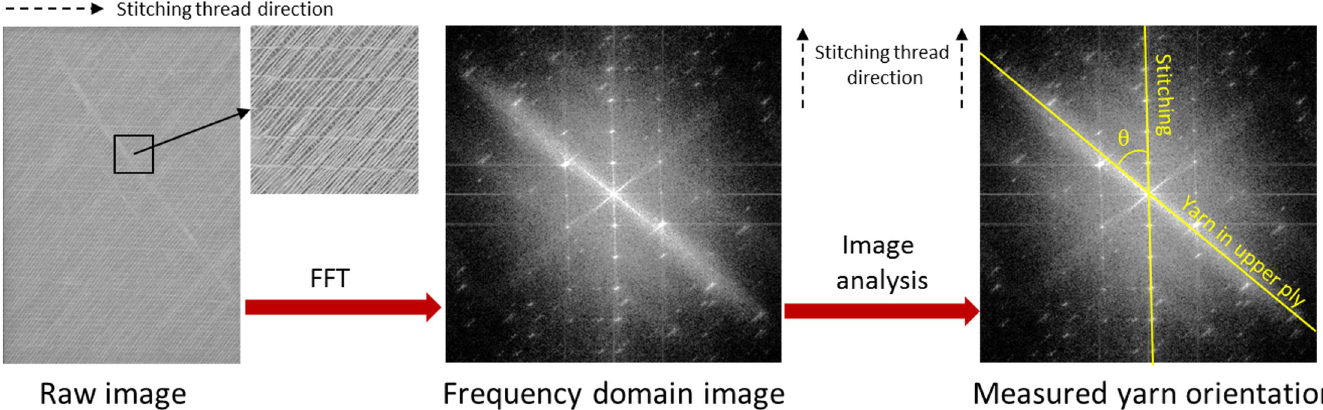
Fig 2. Illustration of the Fast Fibre Orientation (FFO) method for measurement of yarn orientation in a biaxial fabric using 2D Fast Fourier Transformation (FFT) and image analysis.